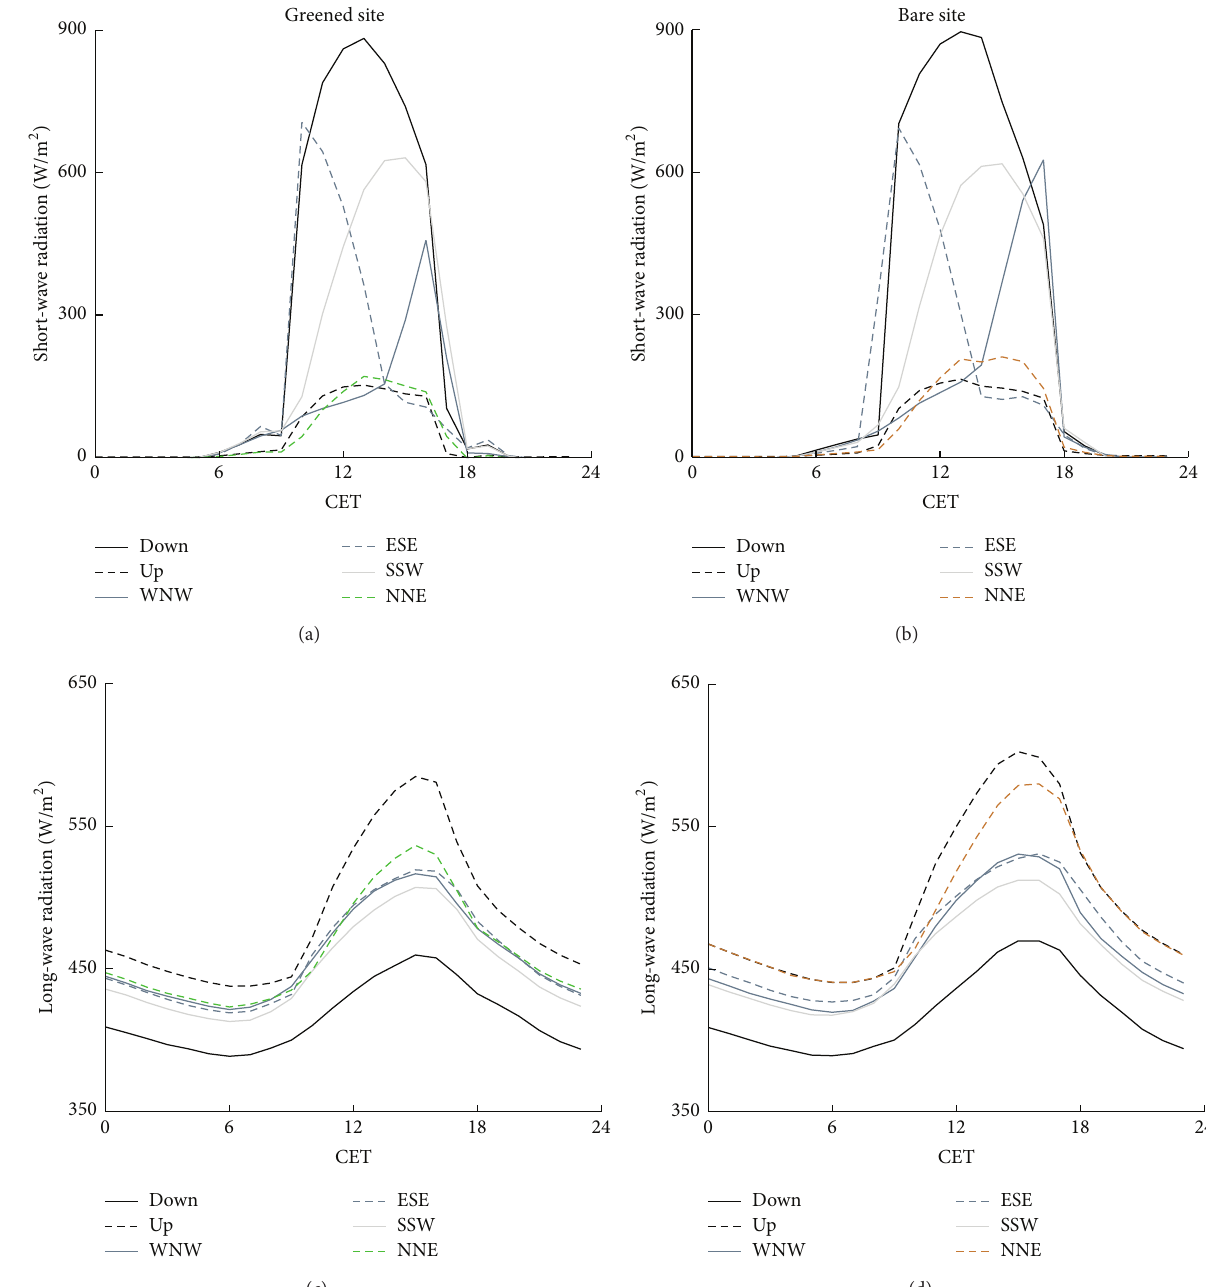
Figure 5: Short-wave radiation at the greened (a) and the bare (b) site and long-wave radiation at the greened (c) and the bare (d) site on 7, 23, 2013. All components used to calculate mean radiant temperature are represented, which are up- and downward radiation (up, down) and radiation from the cardinal points (west-northwest (WNW), east-southeast (ESE), south-southwest (SSW), and north-northwest (NNE) (direction from the